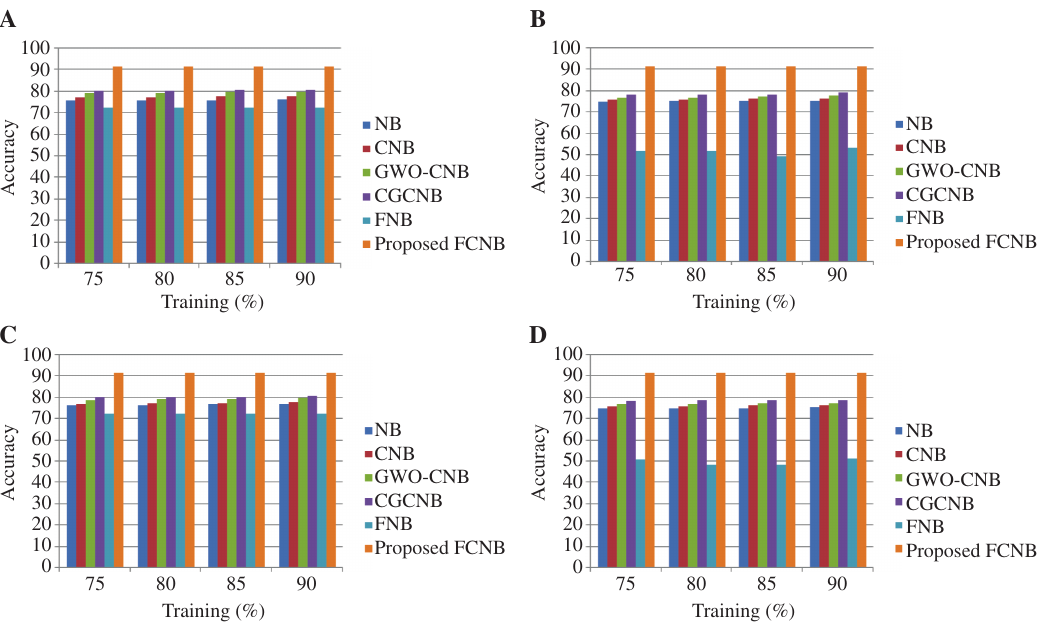
Figure 3: Comparative Analysis of the FCNB Classifier Based on Accuracy. For mapper = 4 in (A) localization dataset and (B) skin dataset. For mapper = 5 in (C) localization dataset and (D) skin dataset.